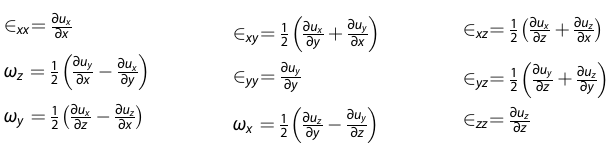
Table 1. Lattice strain tensor components and lattice rotations. The representation of lattice strain and rotation in Fig. 5 follow this